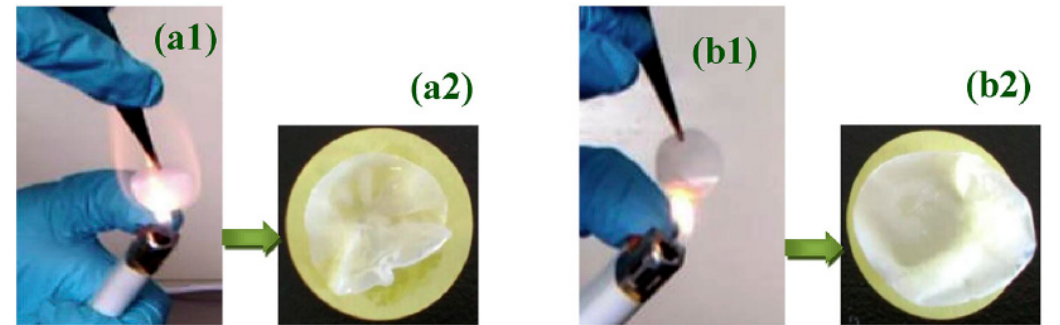
Figure 9. Combustion test of the MS5 (SiO 2 :Al 2 O 3 = 5:5) membrane immersed in commercial carbonated organic liquid electrolyte before ( a1 ), and after ( a2 ) the burning test; and the combustion test of the membrane immersed in the ionic liquid electrolyte before ( b1 ), and after ( b2 ) the burning test [13]. Reprinted with permission by Elsevier from Application of the imidazolium ionic liquid based nano-particle decorated gel polymer electrolyte for high safety lithium ion battery; M. Li, Y. Liao,